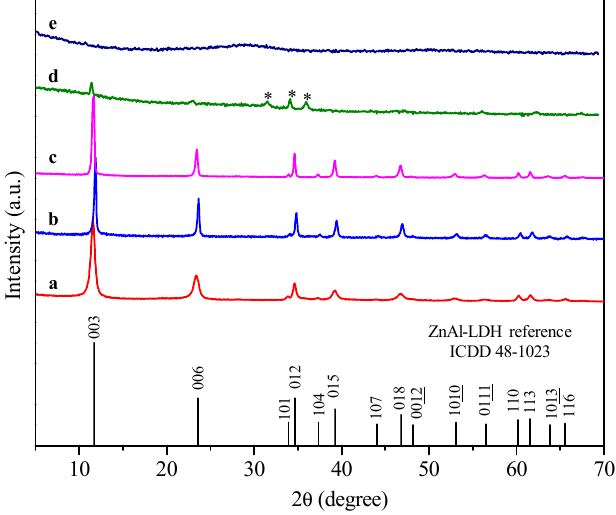
Figure 1. XRD pattern of the samples: ( a ) Zn 2.0 Al 1.0 , ( b ) Zn 2.0 Al 0.75 Gd 0.125 Dy 0.125 , ( c ) Zn 2.0 Al 0.5 Gd 0.25 Dy 0.25 , ( d ) Zn 2.0 Al 0.25 Gd 0.37 Dy 0.37 and ( e ) Zn 2.0 Gd 0.5 Dy 0.5 .